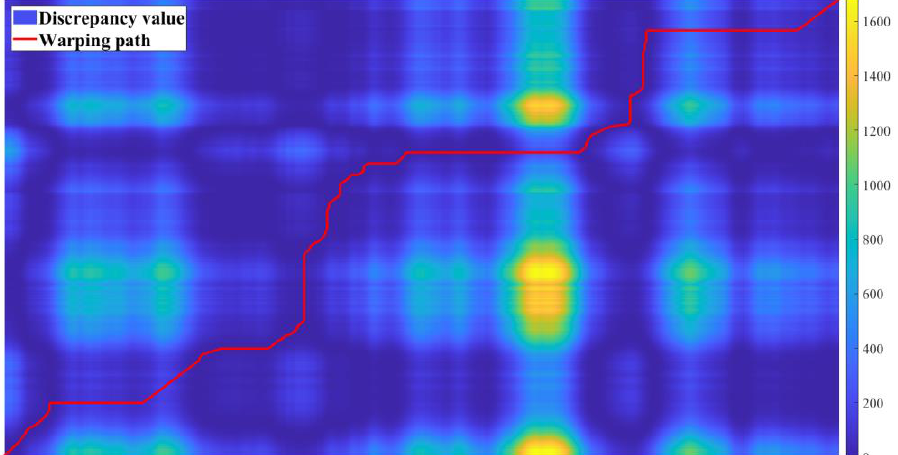
Figure 10. Distance matrix and warping path visualization for the 1st round test.